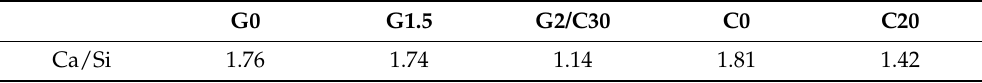
Table 4. Ca/Si molar ratio estimated by EDS line